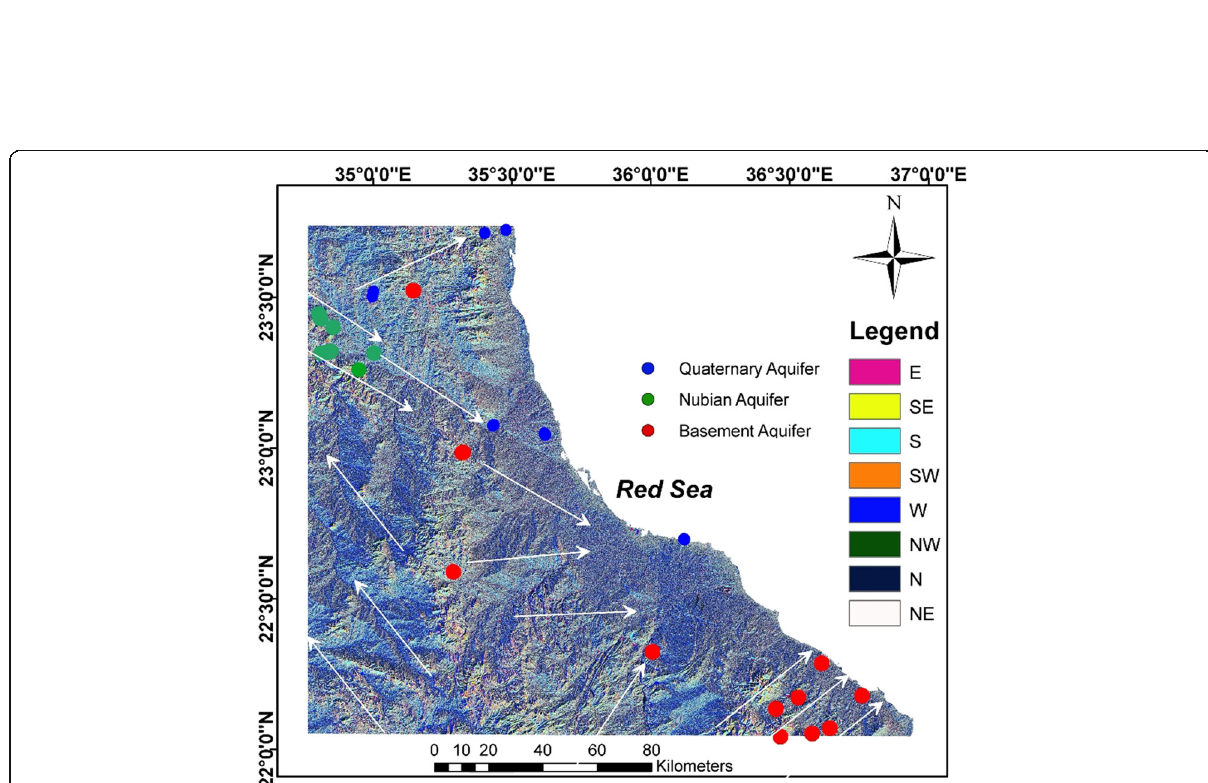
Fig. 11 Flow direction layer where that surface water runs with the general